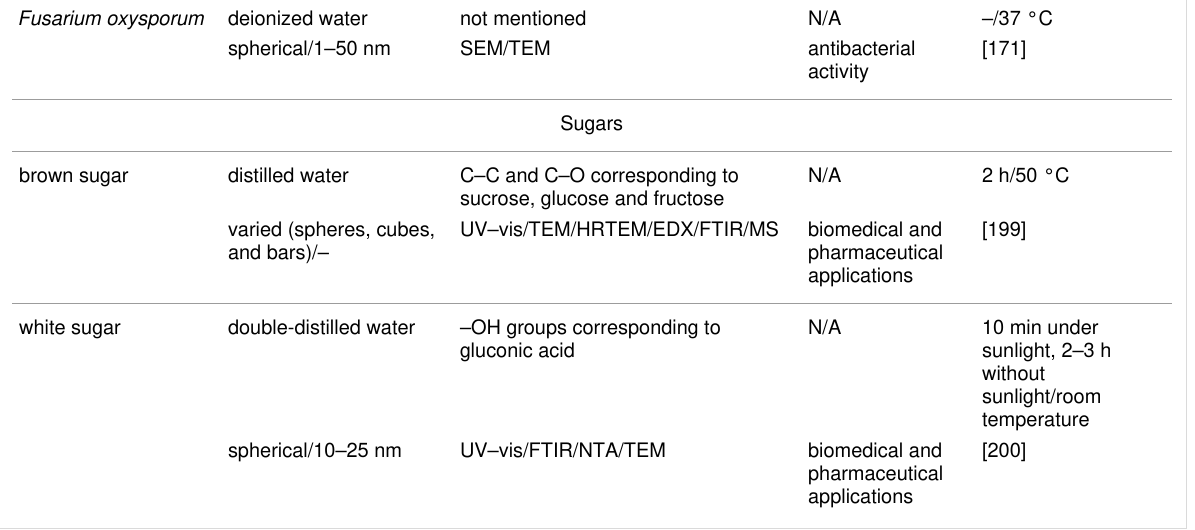
Table 2: A review of various green processes, reaction conditions, necessary functional groups, and characterization techniques used for the synthe- sis of silver nanostructures with different sizes and morphologies along with their application.